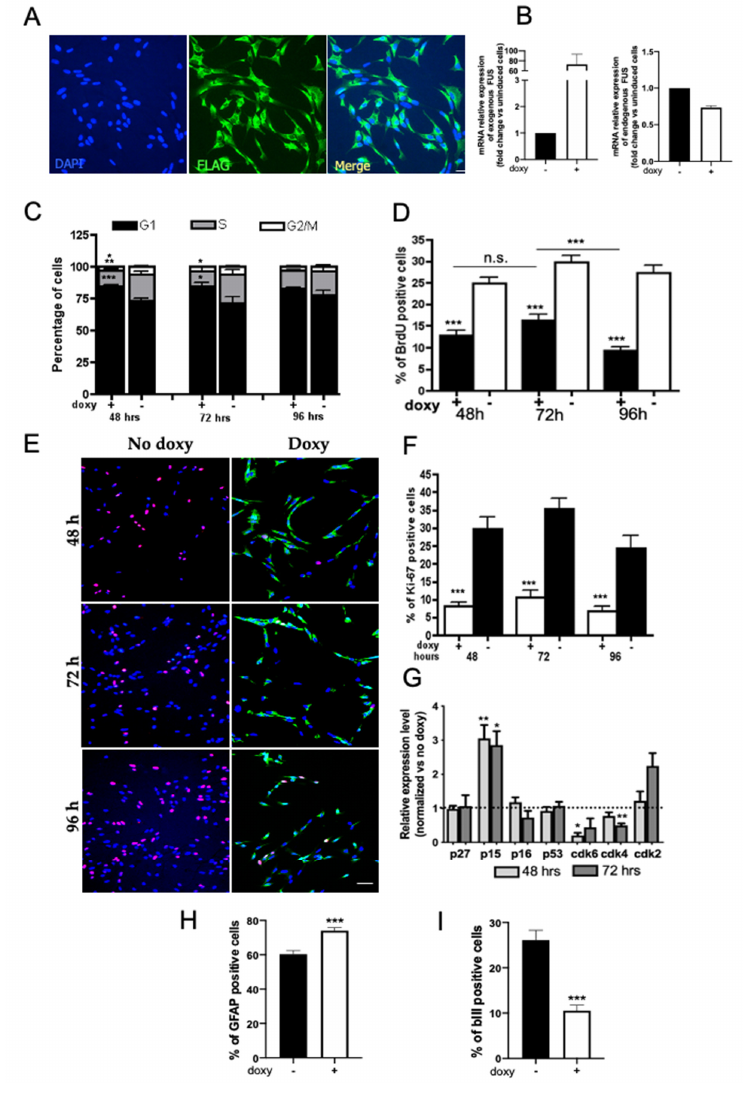
Figure 5. Mutant FUS expression impairs proliferation and neuronal differentiation of NSPCs. ( A ) Representative immunofluorescence images of proliferating NSPCs expressing mutant hFUS (green) after 48 h in the presence of doxycycline. The exogenous protein, detected by an anti-FLAG antibody, shows a mainly cytoplasmic distribution, as expected for the mutated protein. Cell nuclei are stained in blue. Scale bar 30 µm. ( B ) RT-PCR quantification of transgenic and endogenous FUS expression in proliferating NSPCs. Graphs show that human mutant FUS is strongly induced by doxycycline administration while endogenous FUS expression remains unchanged. ( C ) Cytofluorimetric analysis of proliferating mutant FUS NSPCs at 48, 72 and 96 h from transgene induction. ( D ) Quantification of the percentage of BrdU-incorporating cells. NSPCs were grown in expansion medium supplemented with or without doxycycline and analyzed between 48 and 96 h. ( E ) Representative images of NSPC maintained for 48, 72, and 96 h in expansion medium supple- mented with or without doxycycline and immunostained for Ki67 (red) and the transgene mutated protein (anti-FLAG, green). Scale bar 30 µ m. ( F ) The graph represents the quantification of Ki76- positive cells at the analyzed time points. ( G ) Graph shows qPCR of G1/G0-related gene expression levels in mutant FUS NSPCs’ proliferating cultures at 48 and 72 h. The values are expressed as a fold change compared to the expression of the same genes in the uninduced cells. ( H , I ) Percentage of neurons ( β III-tubulin + ) ( H ) and astrocytes (GFAP + ) ( I ) obtained from mutant FUS NSPCs differenti- ated in the neuronal differentiation medium for 12 days. Data shown are the mean ± SEM of four independent cell culture preparations. Mann–Whitney test * p < 0.05 ** p < 0.01 *** p <